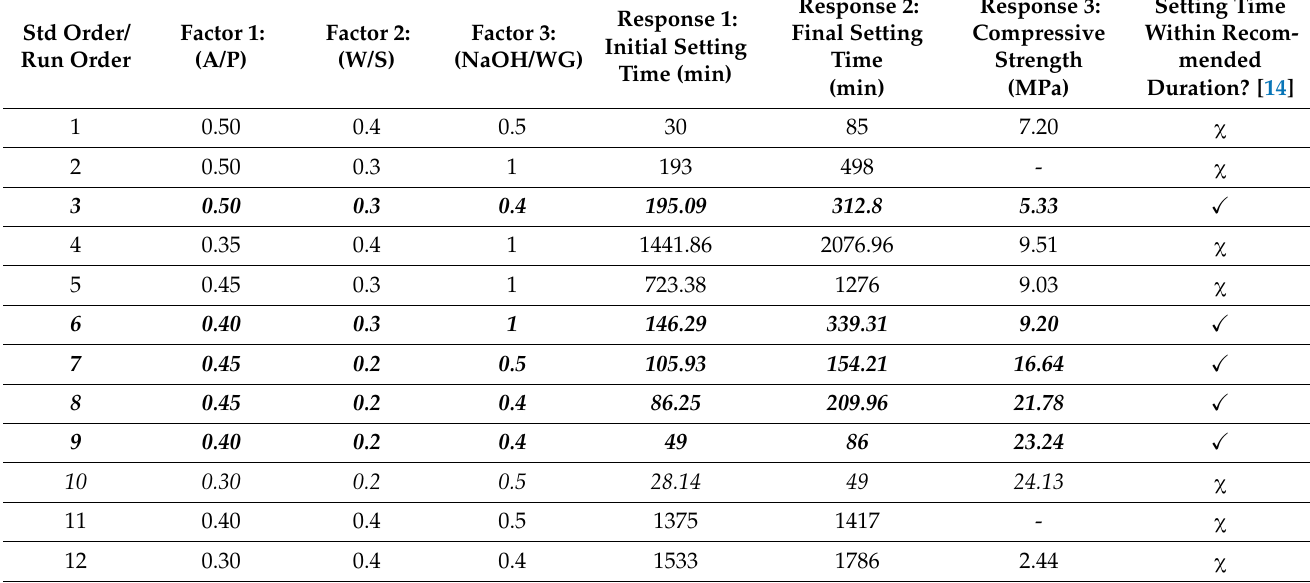
Table 7. Design data and